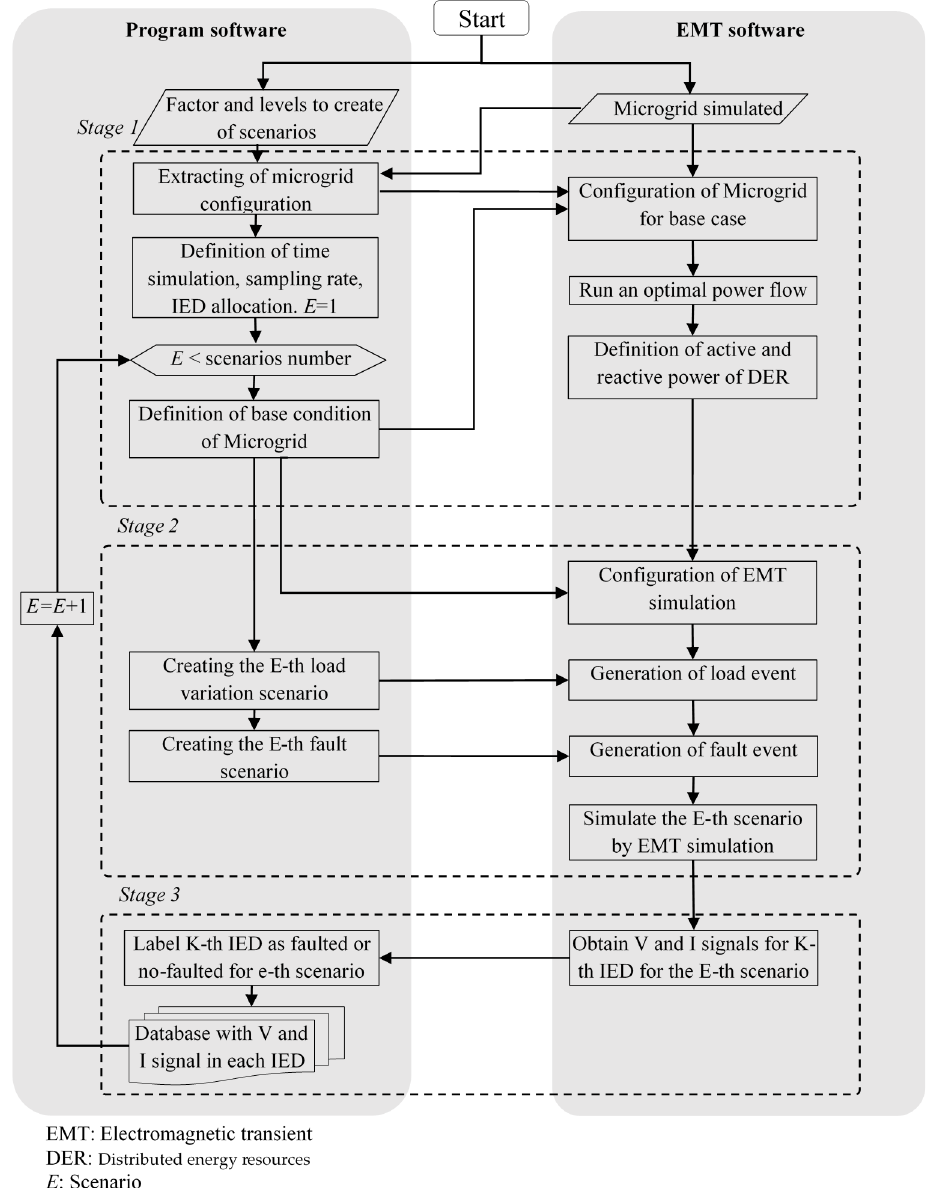
Figure 3. Flowchart of stage 1: database from simulations.